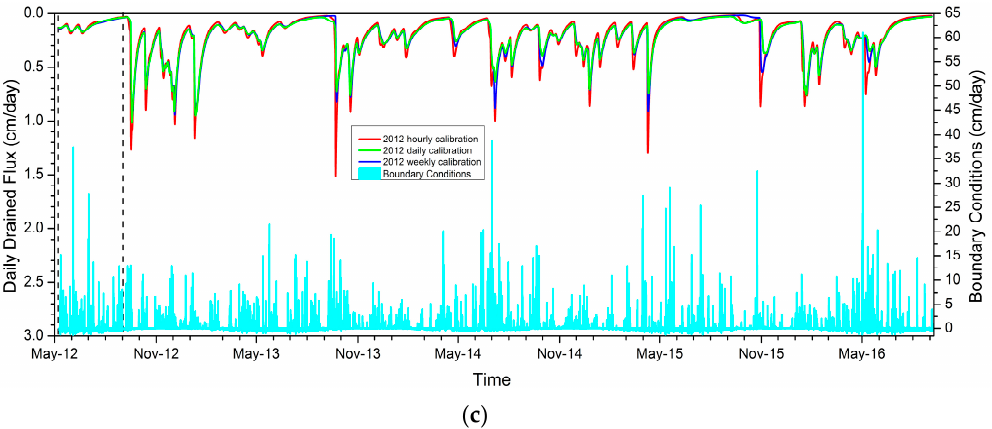
Figure 6. Modeled cumulative ( a ) and daily ( b and c ) drained flux at the depth of 150 cm for the period from May 2012 to September 2016. The model is calibrated using hourly, daily, and weekly data for the periods from April to December 2015 ( b ) and from June to September 2012 ( c ) (calibration period is limited by vertical straight lines on each picture).